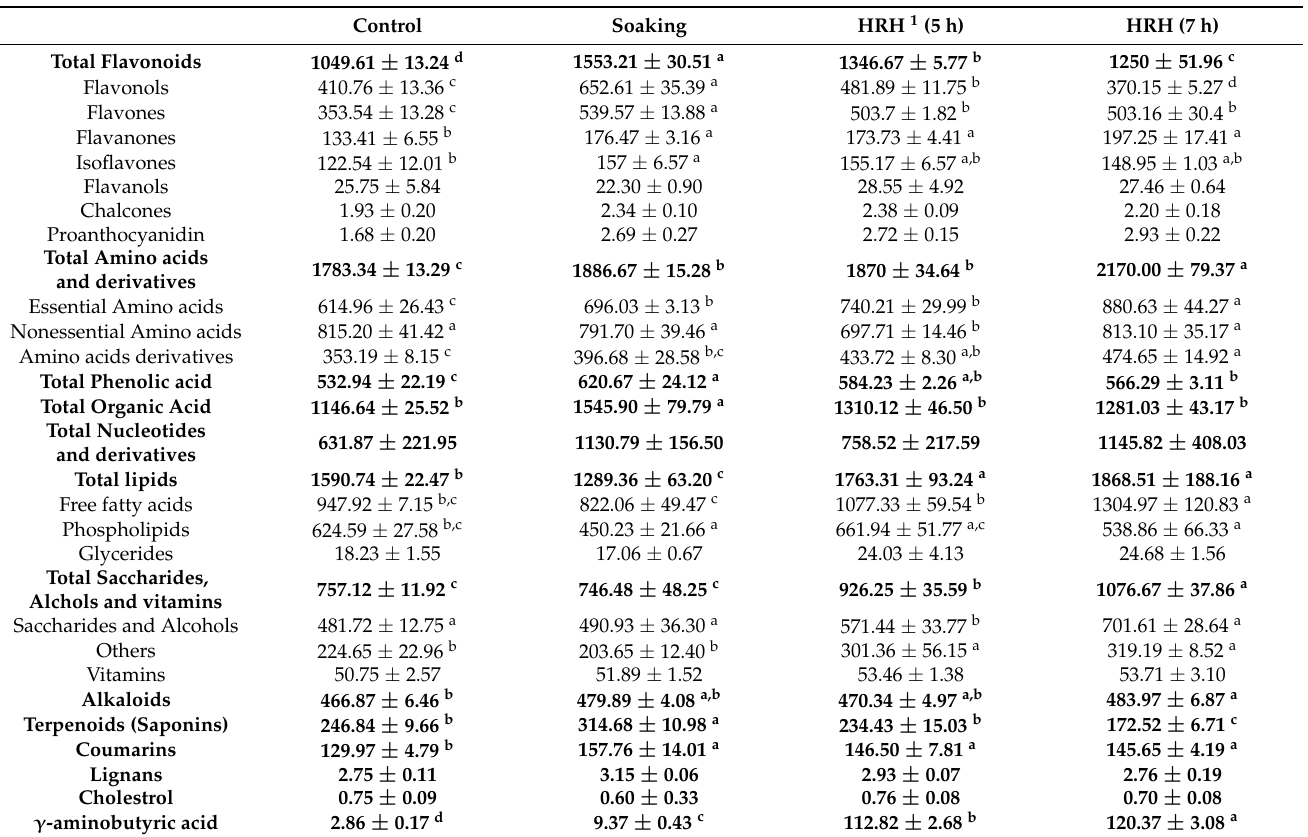
Table 1. Changes of different types of metabolites during GABA-enrichment processing, peak area of each metabolite was used ( × 105). The content of γ -aminobutyric acid was displayed in mg/100 g.